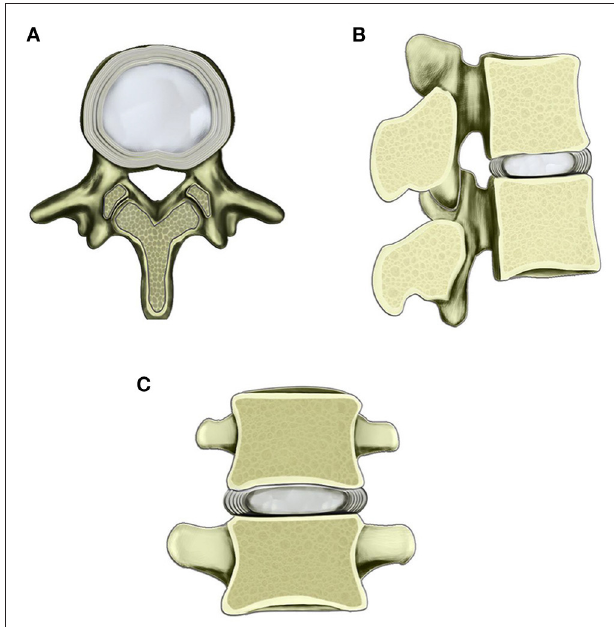
FIGURE 1 | Schematic diagram of the normal lumbar disc within the scope of the vertebral body. (A) Transverse view of normal lumbar disc. (B) Sagittal view of lumbar disc and adjacent vertebral bodies. (C) Coronary view of lumbar disc and adjacent vertebral bodies. The border of the central nucleus pulposus and surrounding AF is